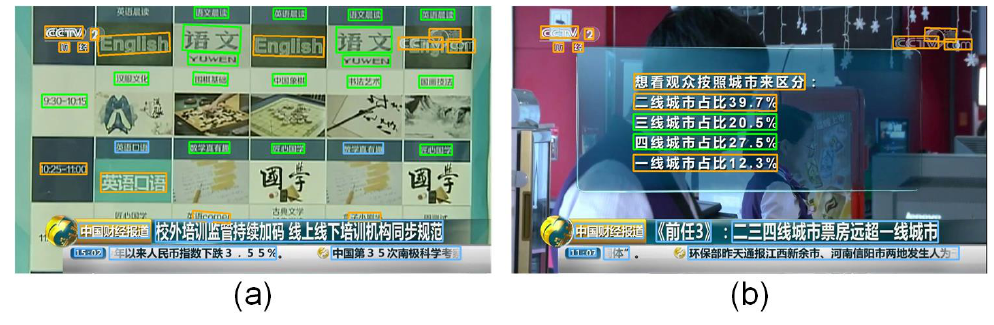
Figure 7. Examples of the failure of the TextDC(PSENet) algorithm on the proposed Text3C dataset. ( a ) Error detection and classification in scene text instances. ( b ) Error classification in layered text instances. Notably, overlaid, layered, and scene text instances are indicated in orange, blue, and green boxes, respectively. Best viewed in color and zoomed